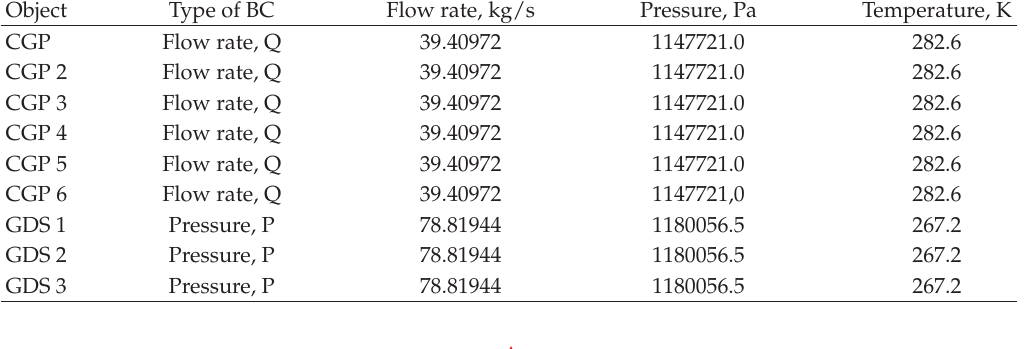
Table 3: Boundary Conditions.